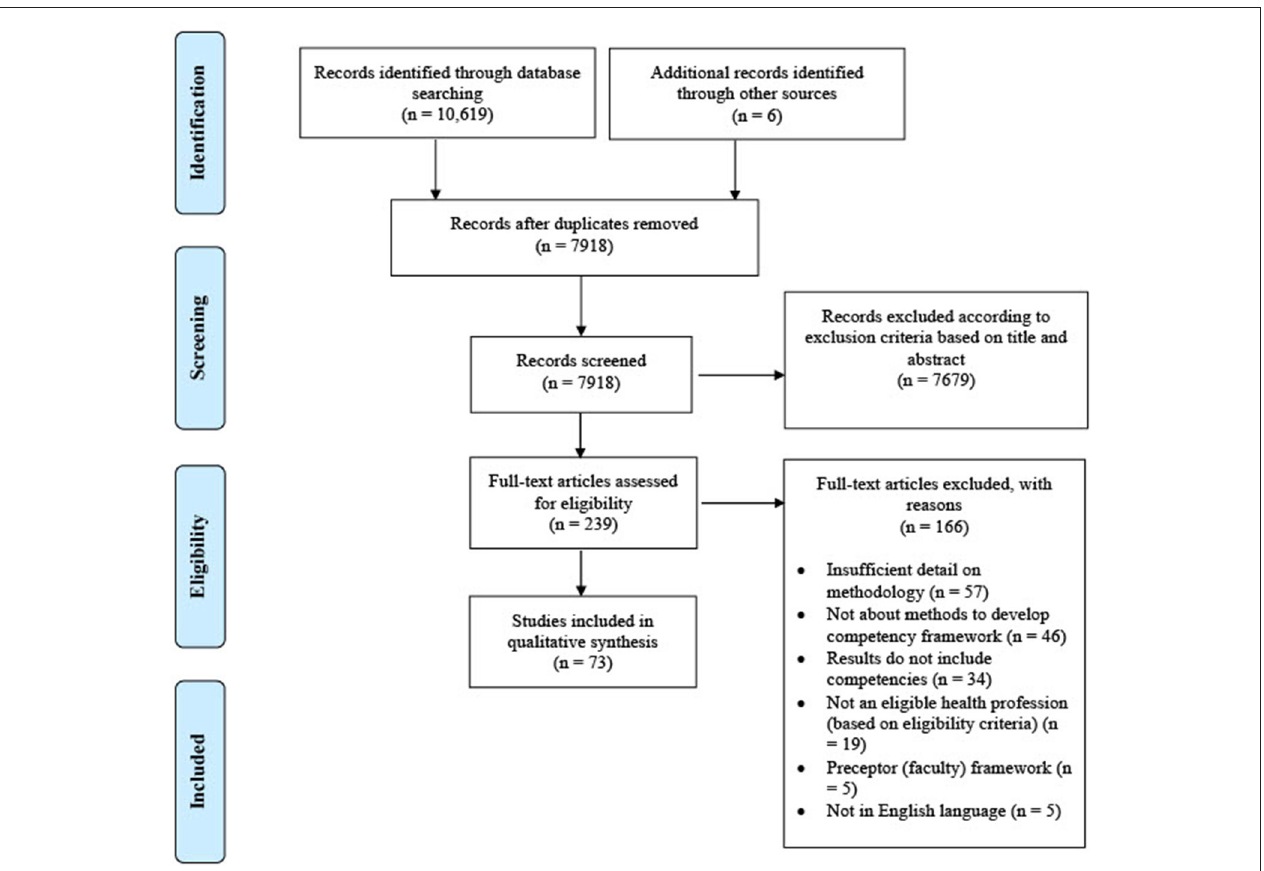
FIGURE 1 | PRISMA flow diagram for identification of studies related to competency framework development methodology in health